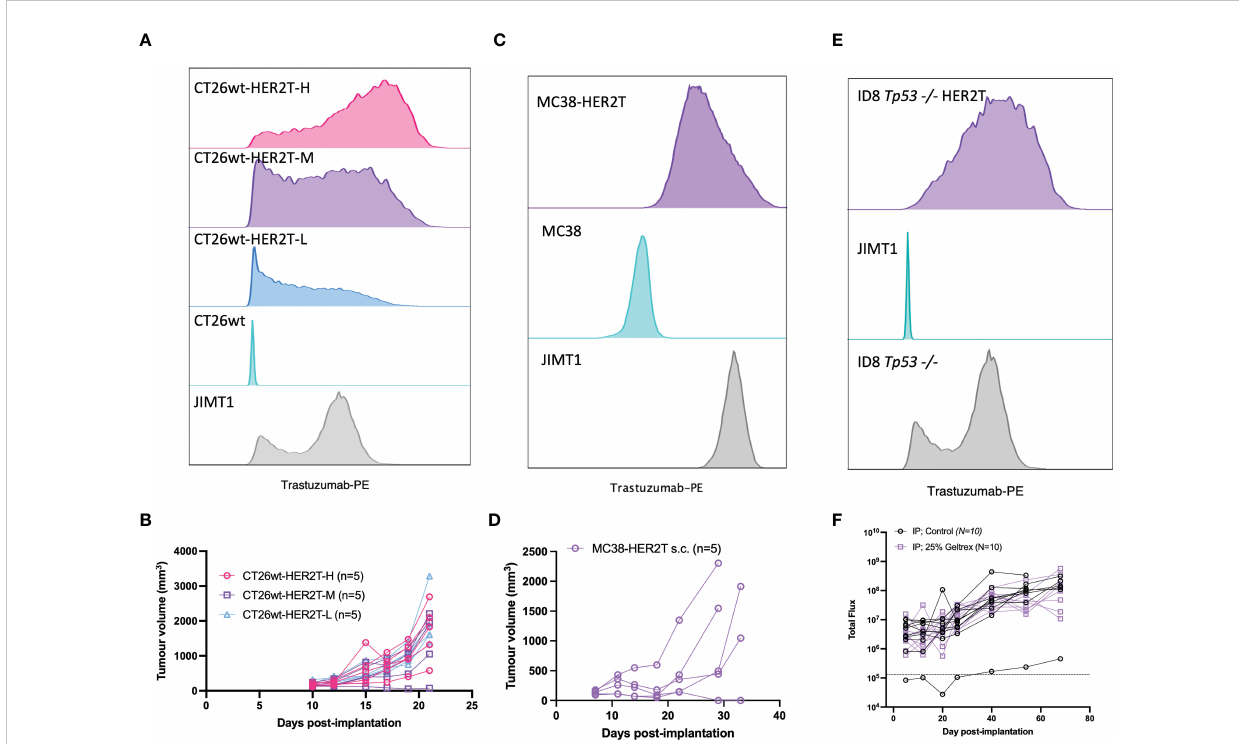
FIGURE 4 HER2T expression does not compromise tumourigenesis in common syngeneic tumour models. (A) CT26wt-HER2T clones expressing different levels of HER2T were assessed by fl ow cytometry. (B) CT26wt-HER2T Cells were implanted s.c. in BALB/c mice (5 x 10 5 cells + Geltrex) in the right fl ank and monitored for tumour progression (n=5 mice per clone). (C) MC38 and MC38-HER2T cells were assessed for HER2T levels by fl ow cytometry. (D) MC38-HER2T cells were implanted s.c. (2 x 10 6 cells + Geltrex) in C57BL/6 mice (n=5) and monitored for tumour progression. (E) ID8 Tp53-/- HER2T Fluc, or control, cells were assessed for HER2T levels by fl ow cytometry. (F) Cells were implanted i.p.,with (n=10) or without (n=10) Geltrex, in C57BL/6 mice. Luminescence was measured by weekly IVIS imaging; the dotted line represents background